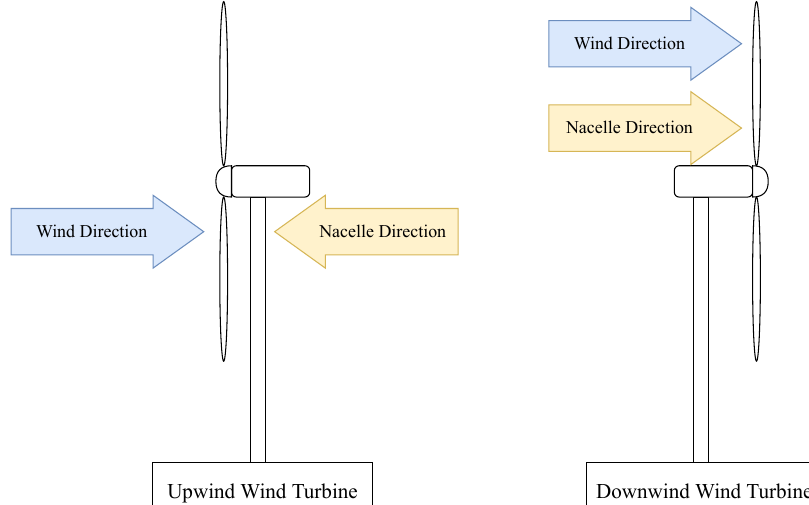
Figure A1. Schematic diagrams of a UWT and